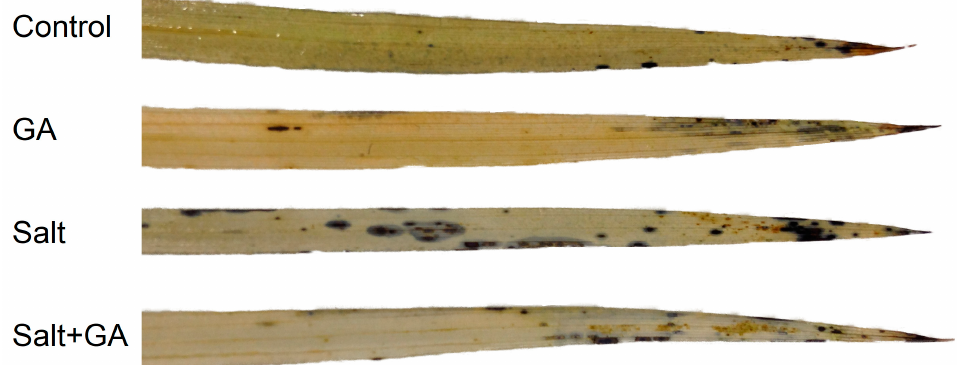
Figure 3. Histochemical detection of O 2• − (indicated by dark blue spots) in the leaf of salt-treated rice ( O. sativa L. cv. BRRI dhan52) seedlings as influenced by GA supplementation. 1 mM gallic acid and 200 mM NaCl are specified by GA and Salt, correspondingly.